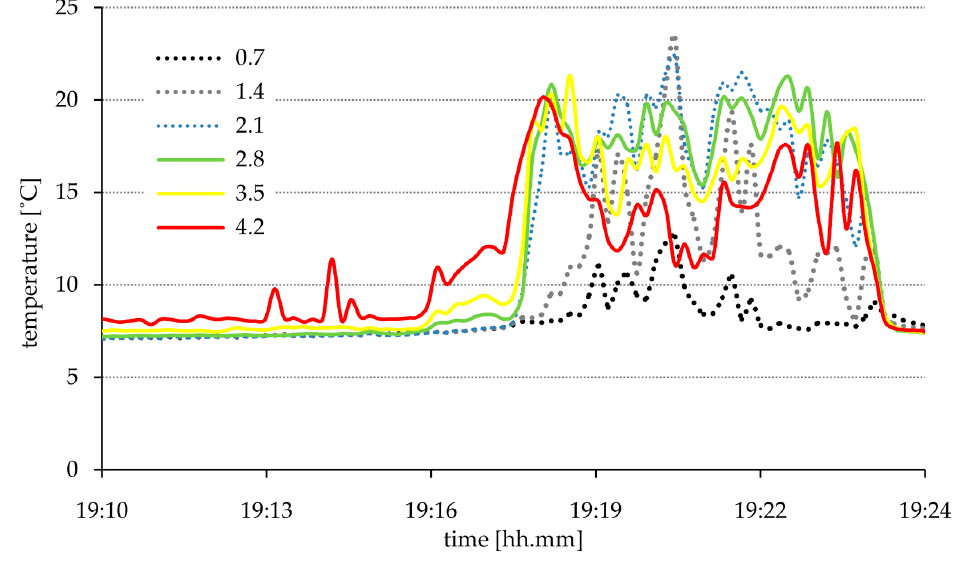
Figure 8. Temperature distribution on windward at 10 m from the last tray. The height of a measuring point is given in meters.